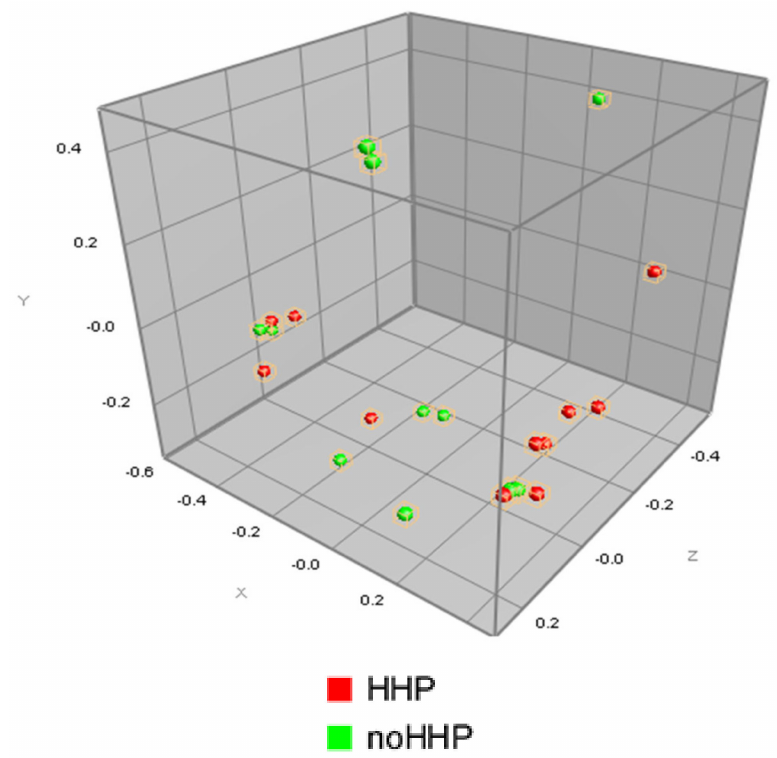
Figure 4. Multidimensional scaling representation of the mass spectra of the 13 strains of Lactobacillus obtained from the unpressured (noHHP -green) and pressured (HHP -red)